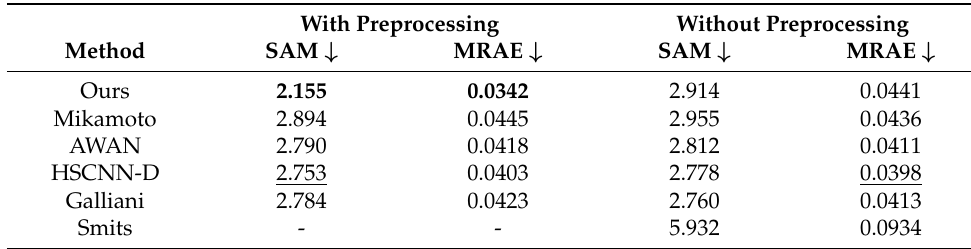
Table 2. Quantitative evaluation of the experiments on the ARAD HS dataset. Bolded and underlined indicate the best and second-best results, respectively.